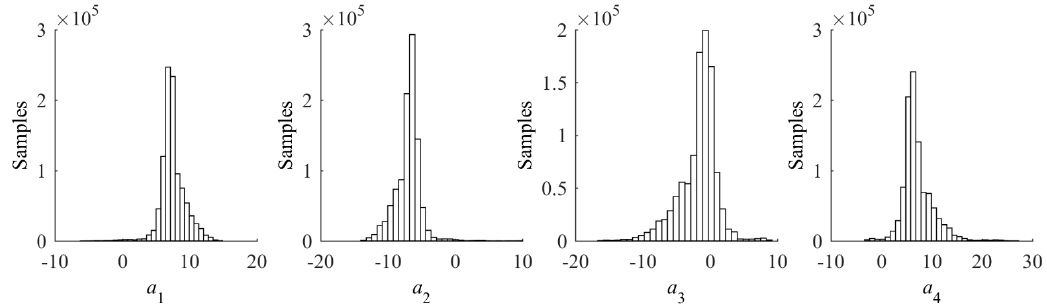
Figure 17. Histograms of the posterior model parameters.